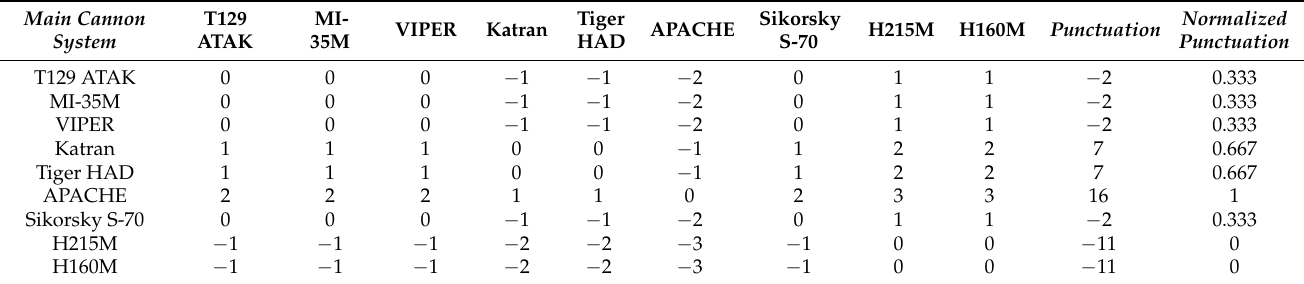
Table 6. Evaluation of alternatives under qualitative criterion Main cannon system .